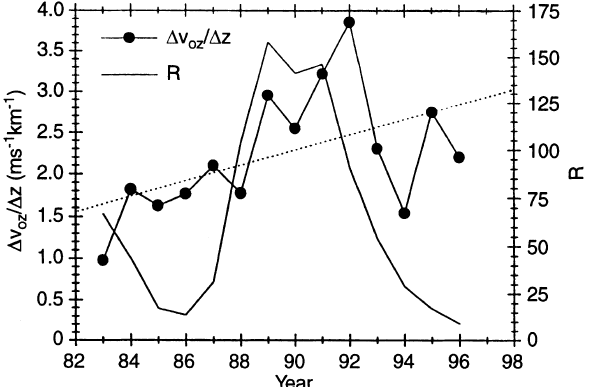
Fig. 4. Time series of Collm summer (June–August) mean vertical gradients of the mesopause zonal prevailing wind at 90 km. The dotted line shows the linear trend. The 13-monthly smoothed sunspot number R is added